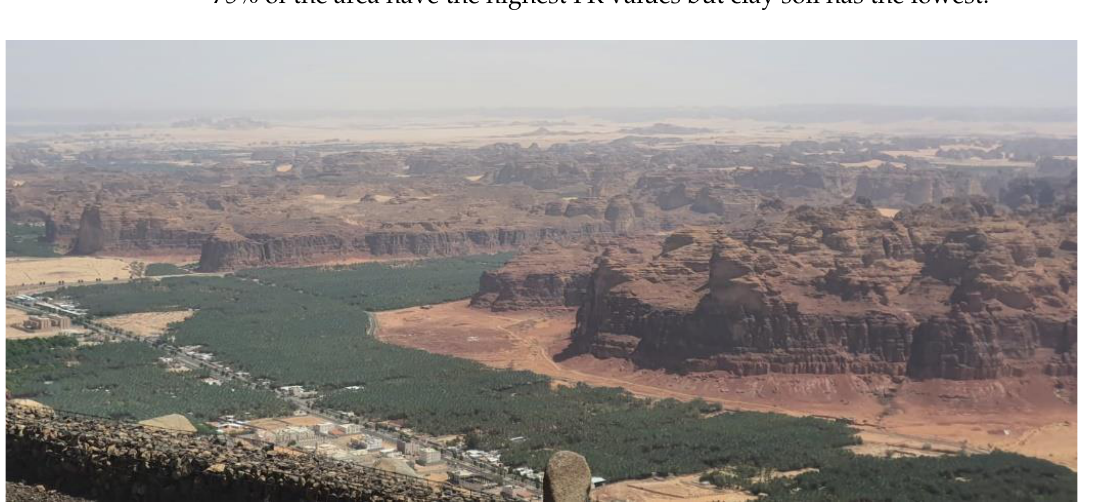
Figure 12. Vegetated areas at Wadi Al Ula Town. These are irrigated using groundwater wells ab- stracted from clastic Paleozoic rocks aquifer. Wadi Al Qura passes through Al Ula town, formed by Tertiary N-S graben system that deformed the Paleozoic rocks.